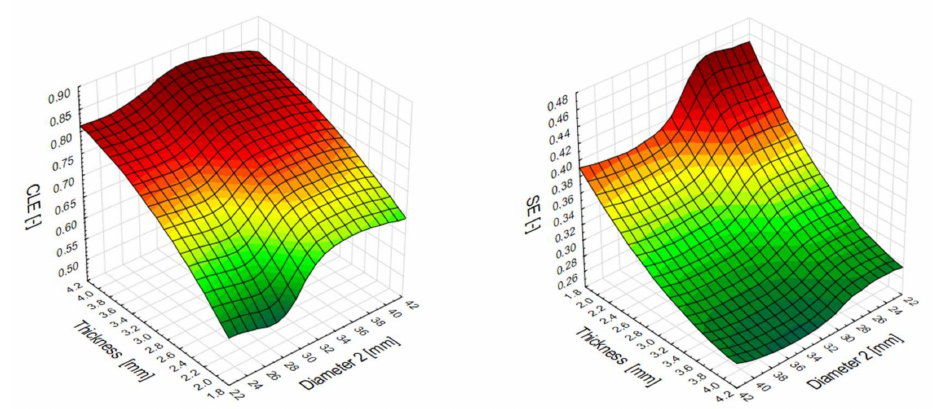
Figure 13. Crush load e ffi ciency (CLE) and stroke e ffi ciency (SE) indicators from the numerical models.